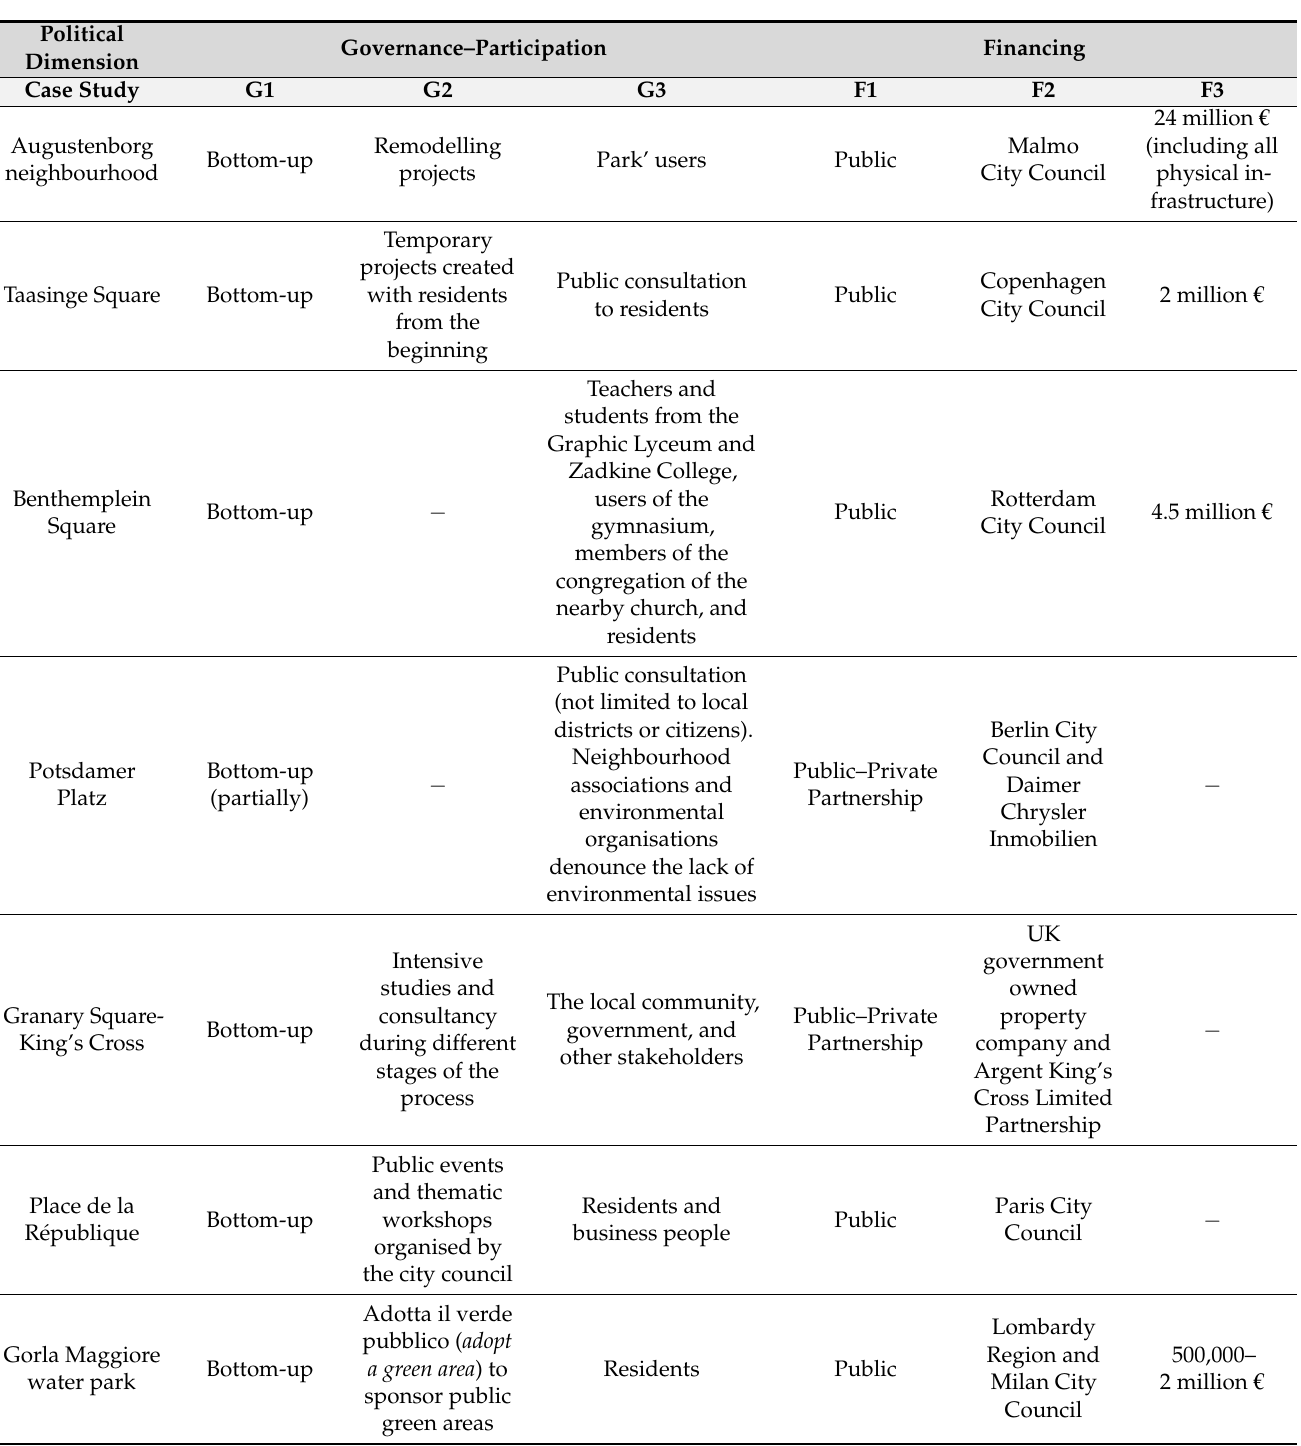
Table 4. The political dimension in case studies: Governance and